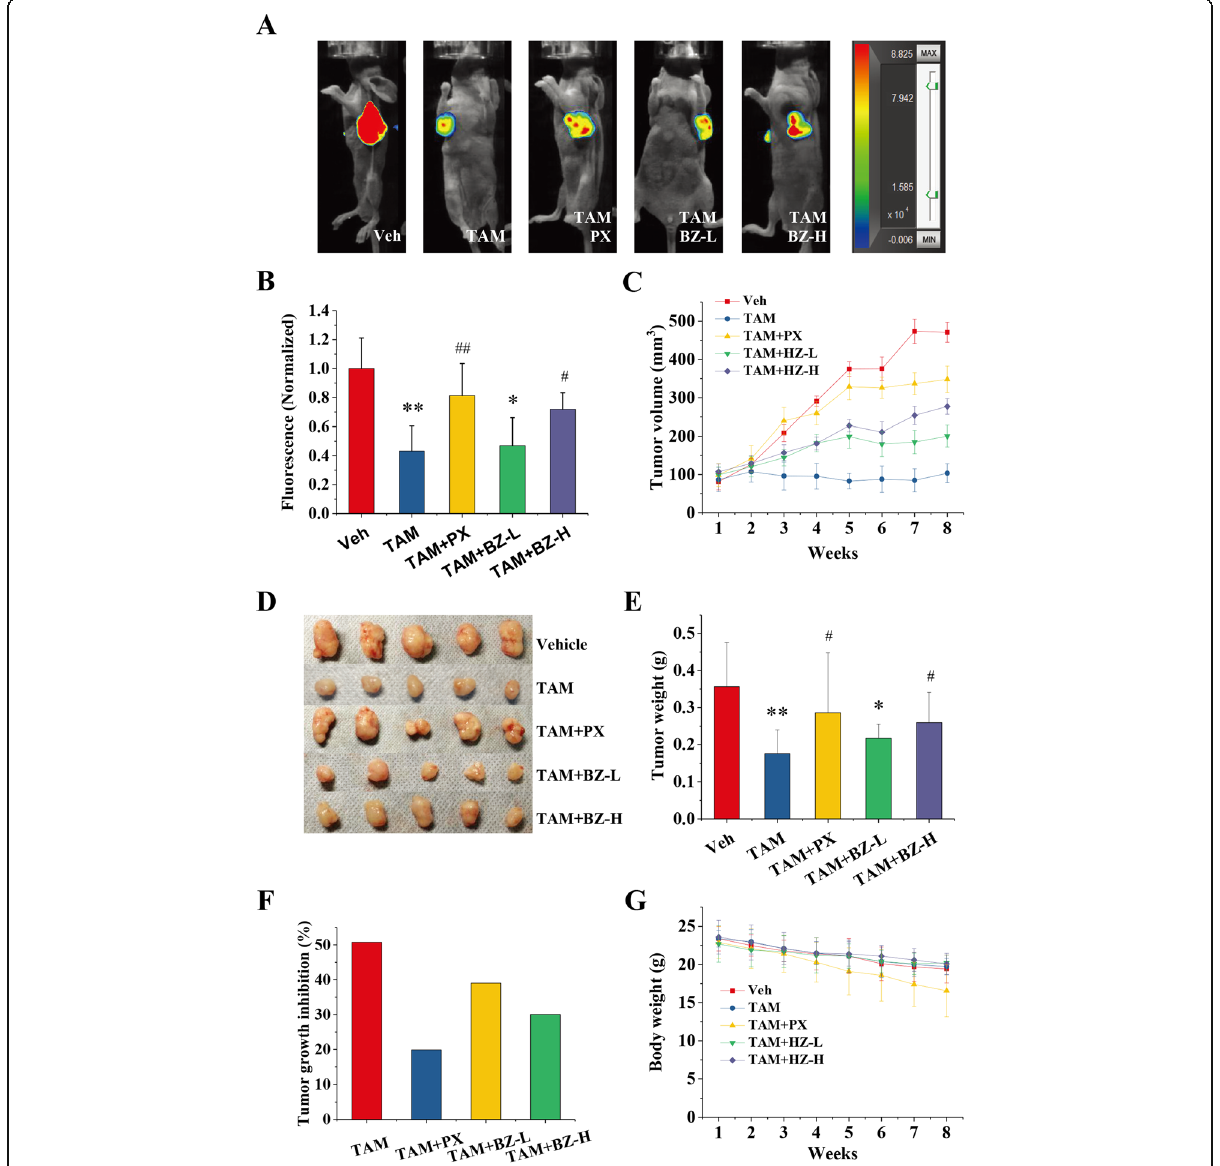
Fig. 2 BZ formula attenuated the effectiveness of tamoxifen against breast cancer in mice. Nude mice were injected with estrogen receptor- positive (ER + ) human breast cancer MCF-7 cells and then treated with 4 mg/kg tamoxifen (TAM) alone or in combination with BZ formula (BZ-L/ BZ-H, 2 or 8 g/kg) or paroxetine (PX, 4 mg/kg). The control group was treated with an equal volume of physiological saline. There were